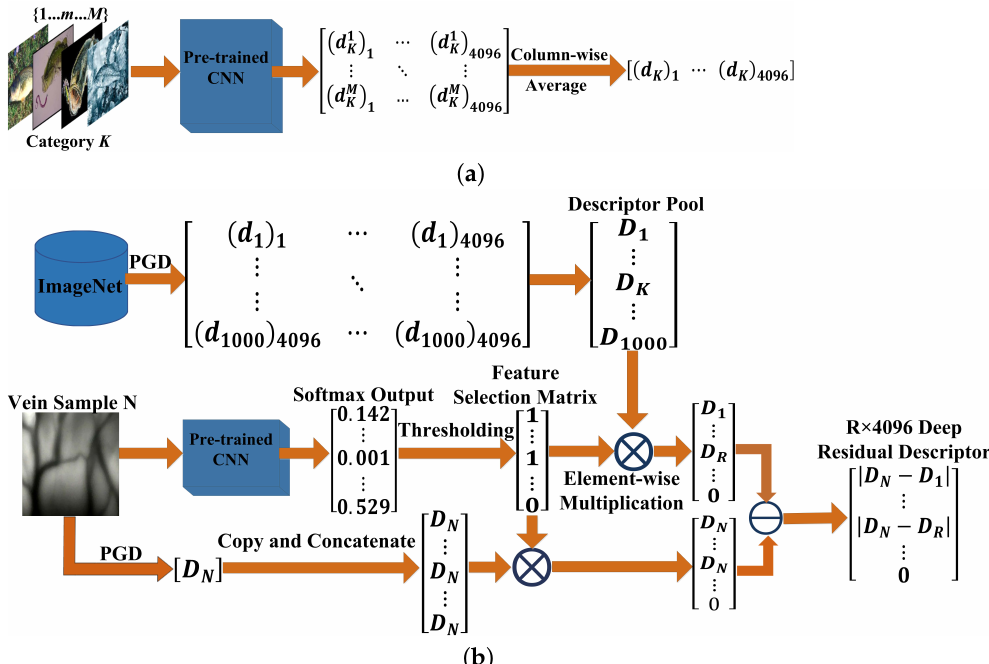
Figure 2. Overview of the proposed deep residual descriptor generation system. ( a ) Procedure of generating descriptors (PGD) from a pre-trained CNN for category K containing M